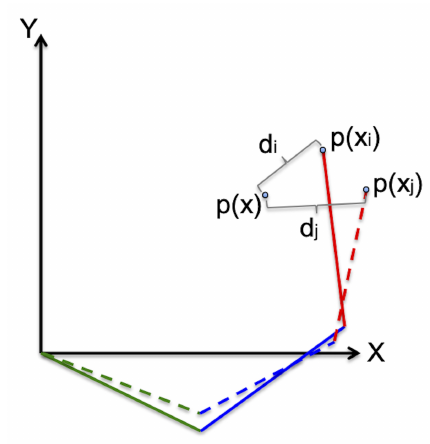
Figure 3. Cost function associated with the x i and x j